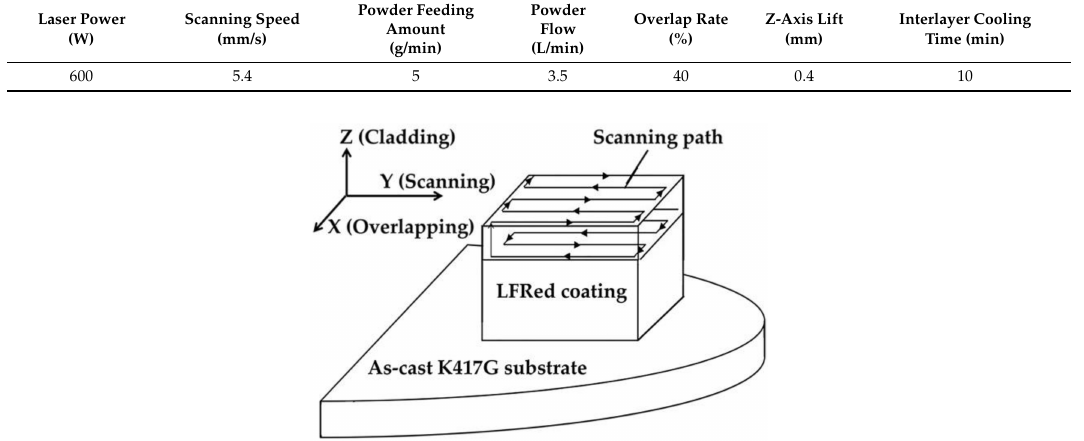
Figure 1. The schematic of laser scanning path. LFR—laser forming